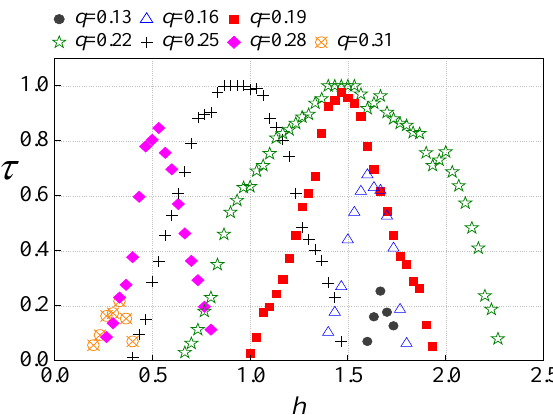
Figure 8. Relationship between τ and h under di ff erent dimensionless discharges ( q ) ( l = 0.5).